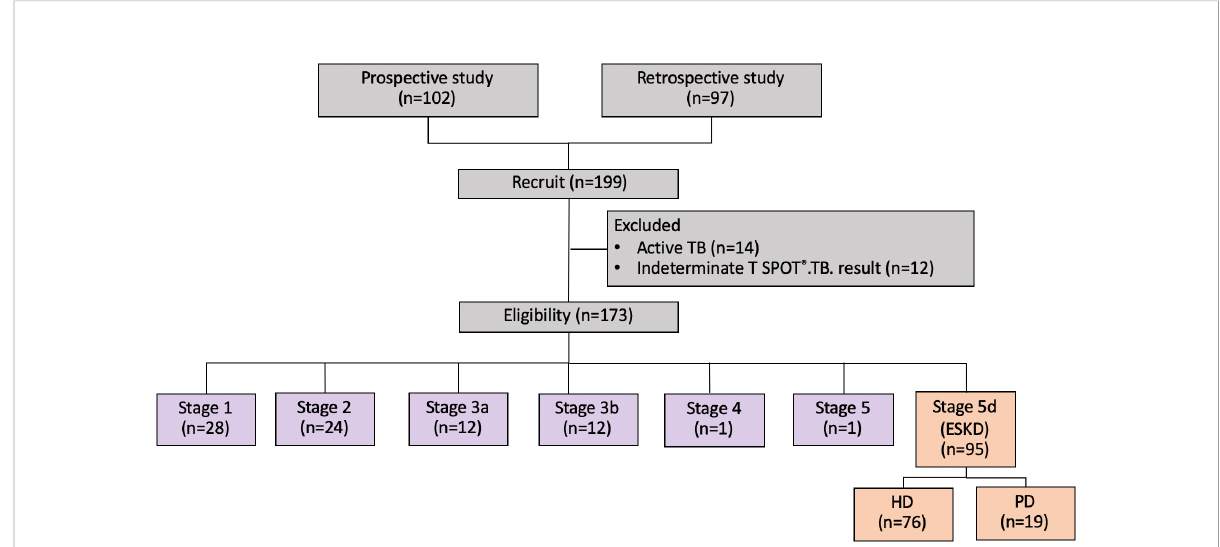
FIGURE 1 Study fl ow chart. ESKD, end-stage kidney disease; HD, hemodialysis; PD, peritoneal